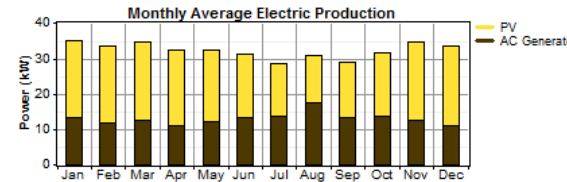
Figure 11: Monthly Average Electric Production for